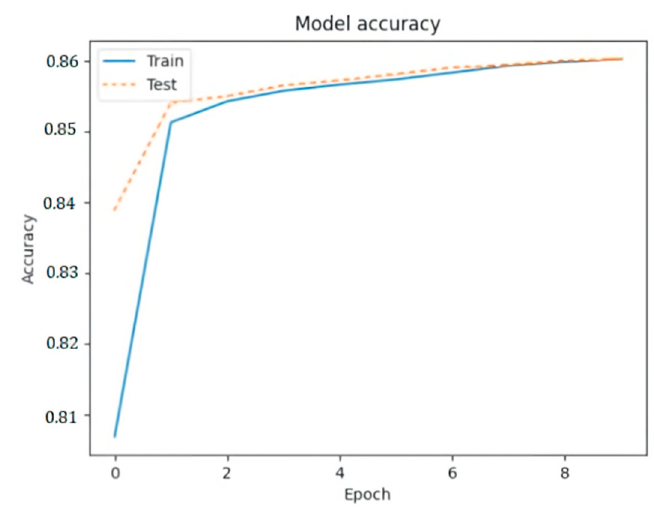
Figure 7. Accuracy Curve